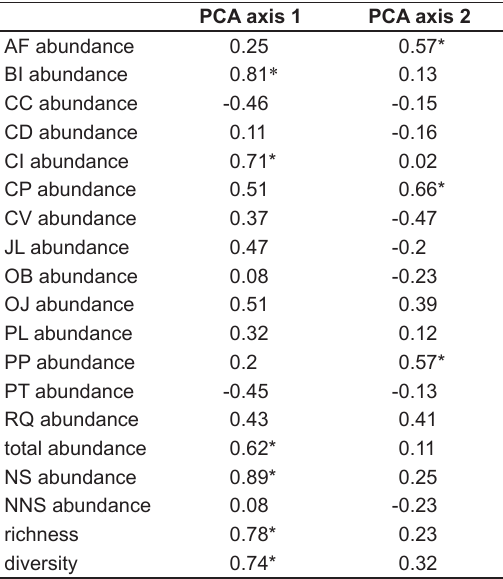
Table 4. Spearman rank correlation coefficients between fish assemblage attributes and specific abundances with PCA scores of environmental variables.